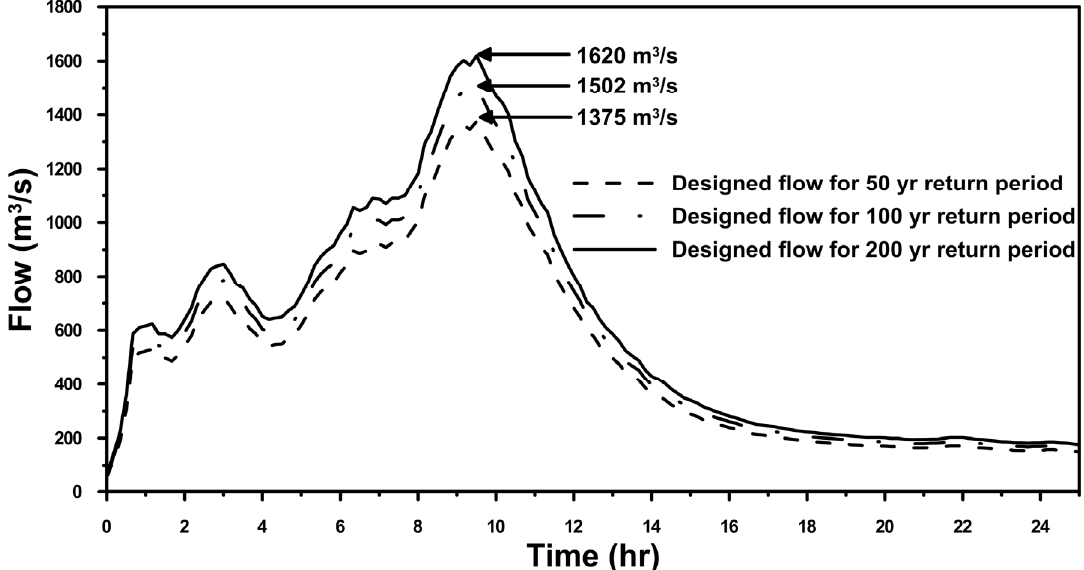
Figure 6. Designed river flow at the upstream boundary for the 50-year, 100-year, and 200-year return